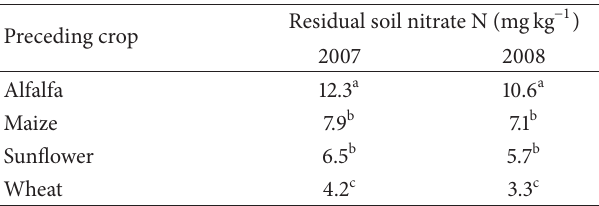
Table 2: Effects of the preceding crop on preplant residual soil nitrate N (0–40 cm